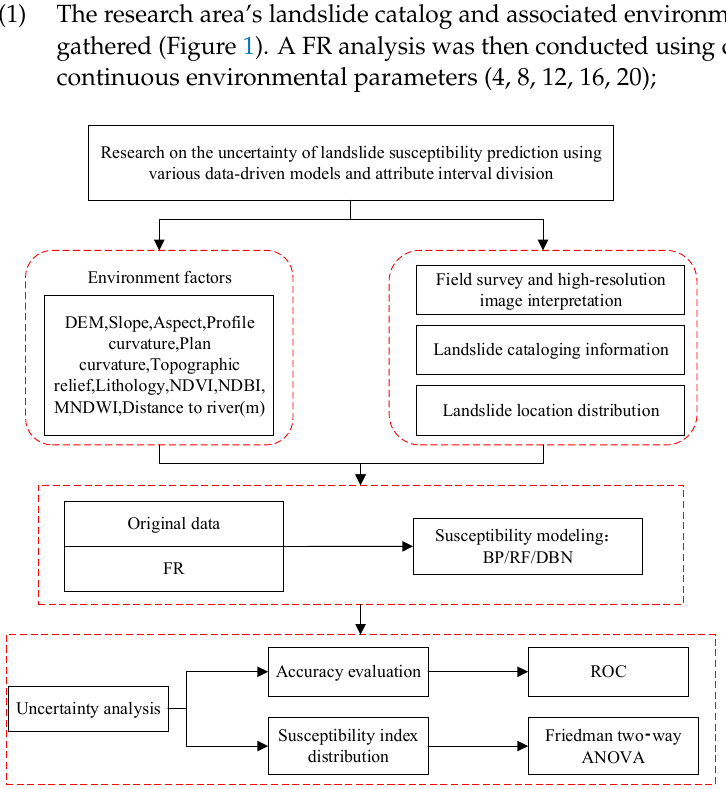
Figure 1. Modeling fl ow chart.